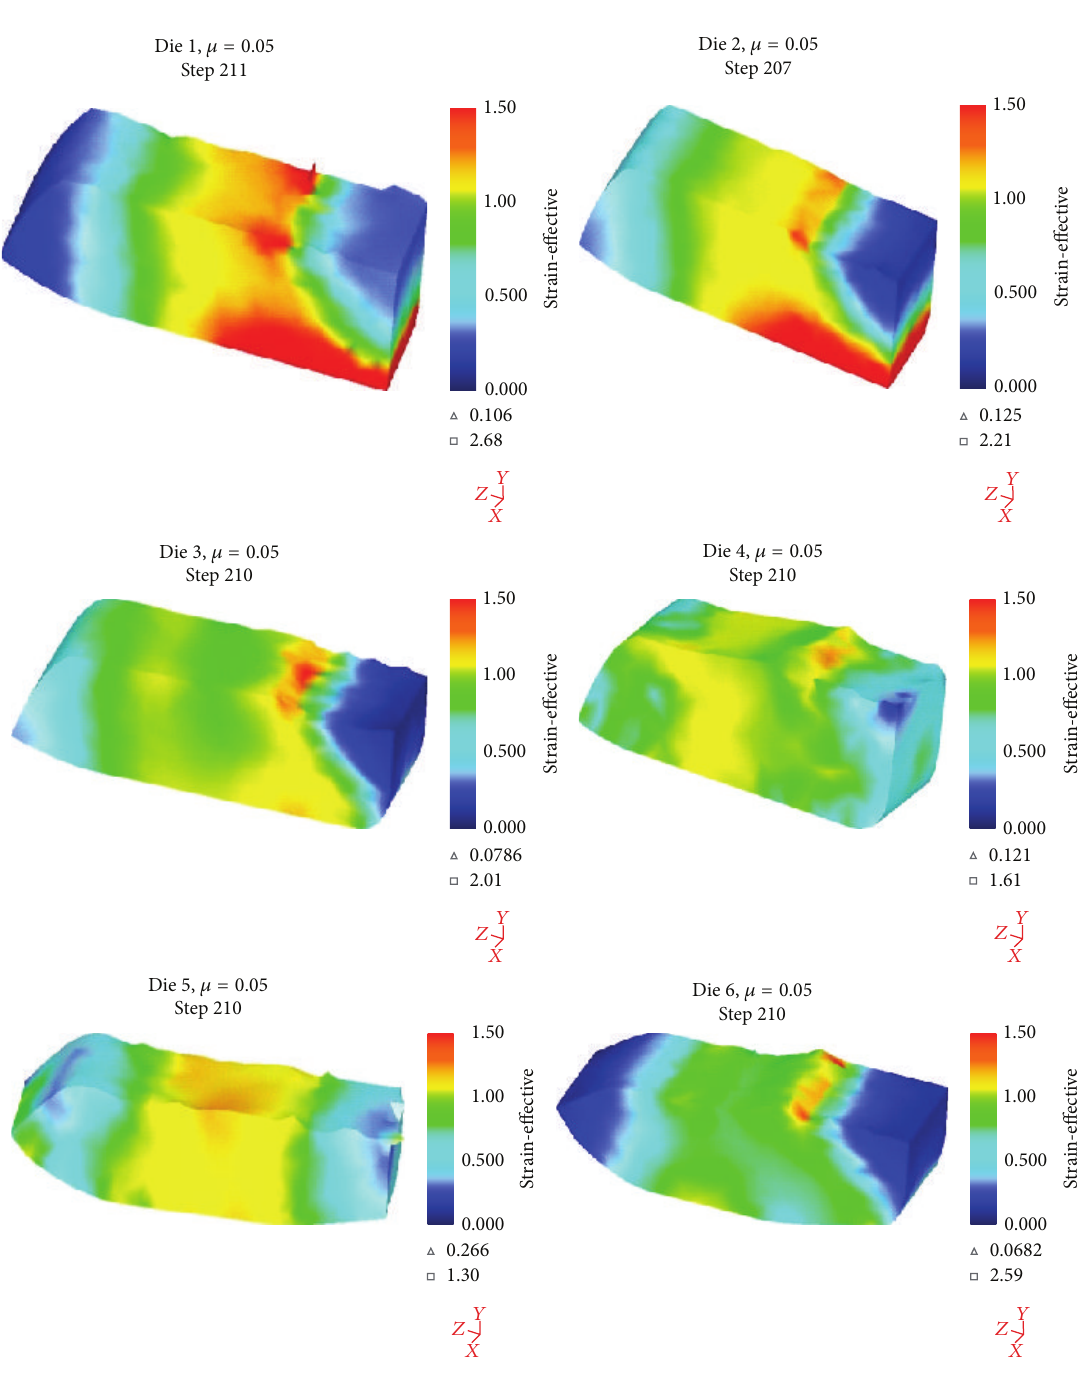
Figure 6: Results of the finite element method analysis of the deformation distribution in the workpieces as a function of the intermediate friction coefficient utilized during the processing with the six-channel configurations of the ECAP die after one